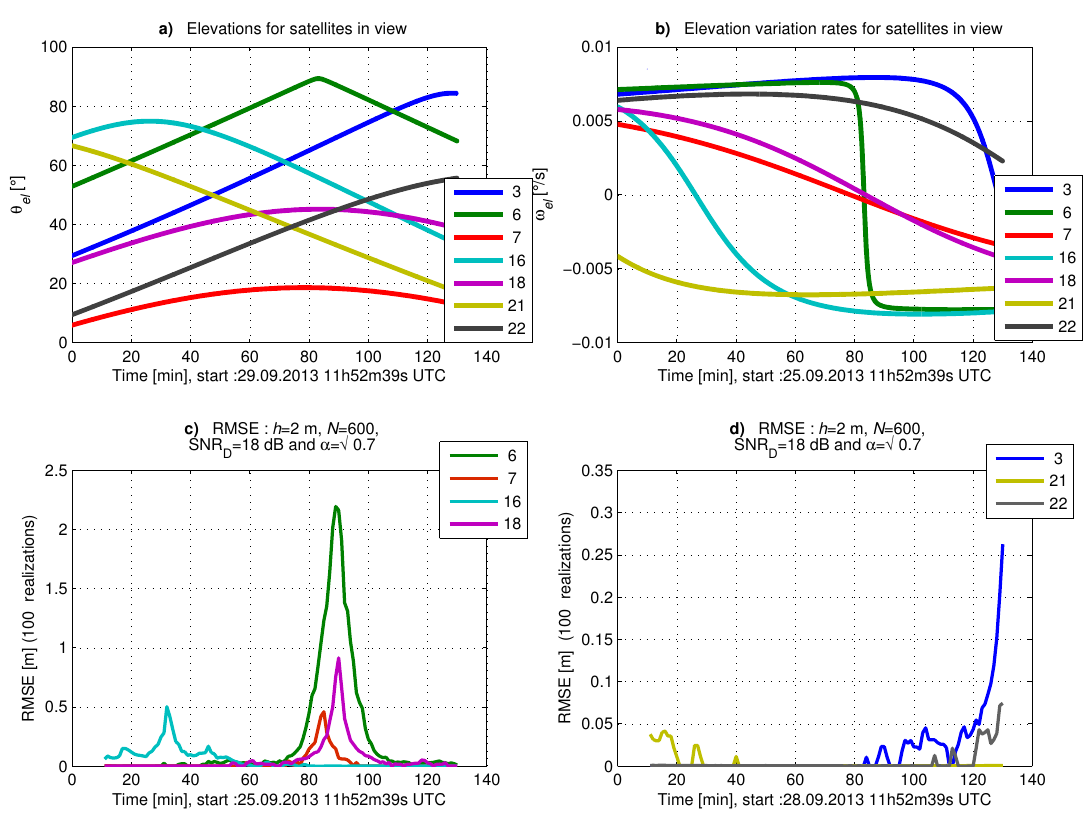
Figure 8. RMSE obtained for height estimation, with the corresponding elevation and elevation rate, for several satellites in view on September 25,